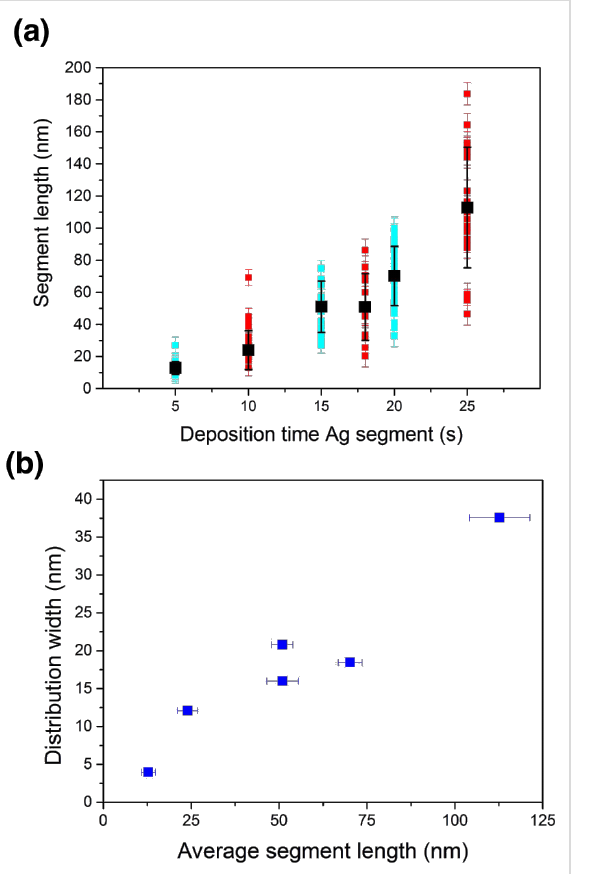
Figure 4: (a) Segment length of the silver segment versus pulse length for wires corresponding to six different nanowire arrays. Cyan blue values correspond to arrays with 25 s deposition time for the Au-rich segments, red values to 37 s deposition time. The black values reveal the average value for each array with its standard deviation. (b) Distrib- ution width given by the standard deviation for the silver segments versus average value of segment length.